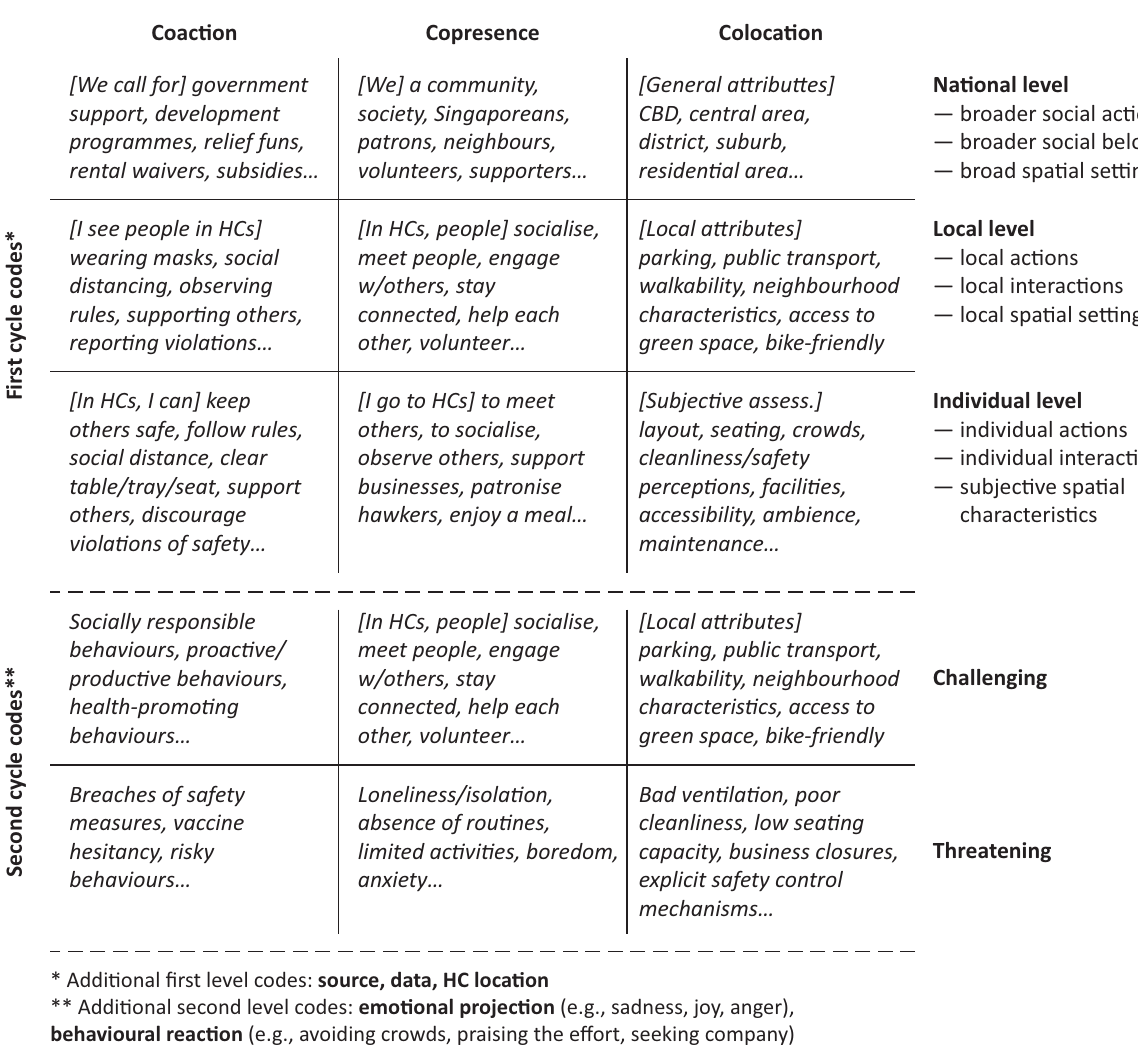
Figure 1. Examples of coding and organising